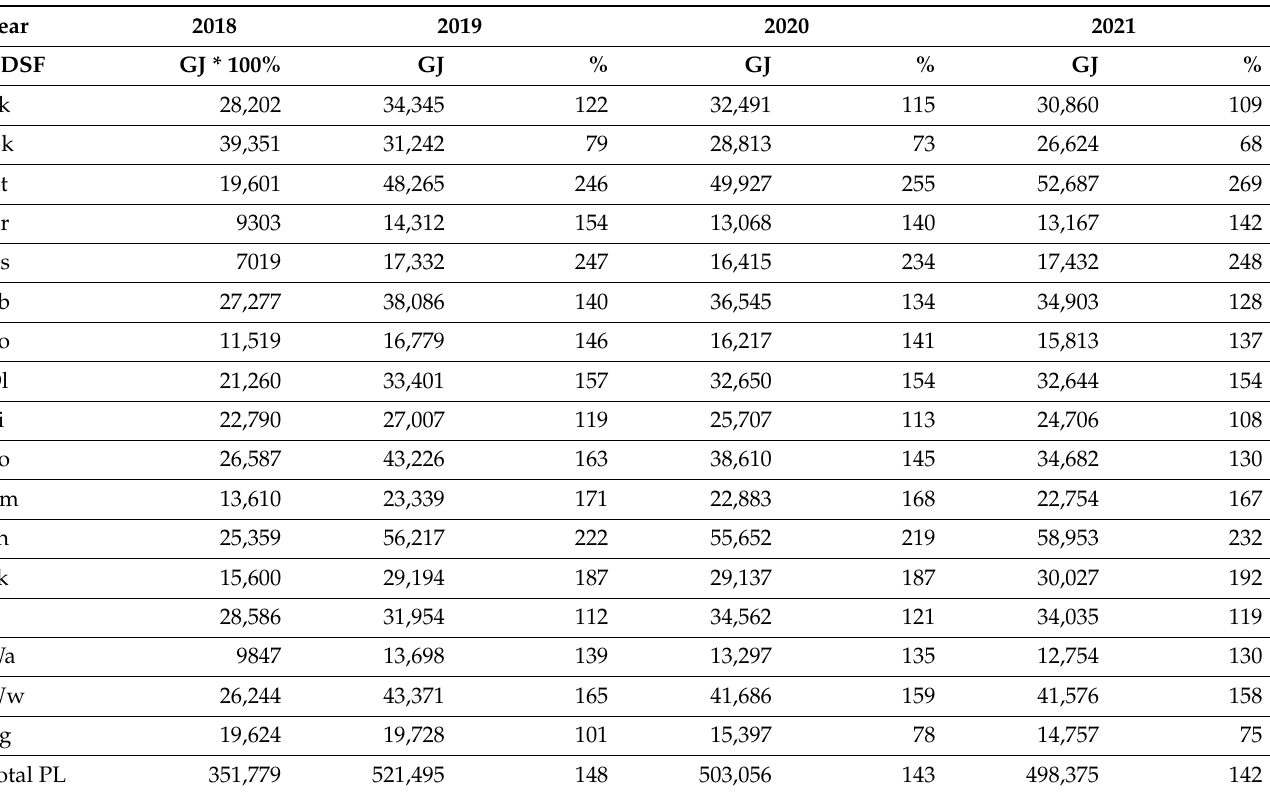
Table 12. Energy potential of the forest biomass in RDSFs in Poland (for a biomass moisture content of